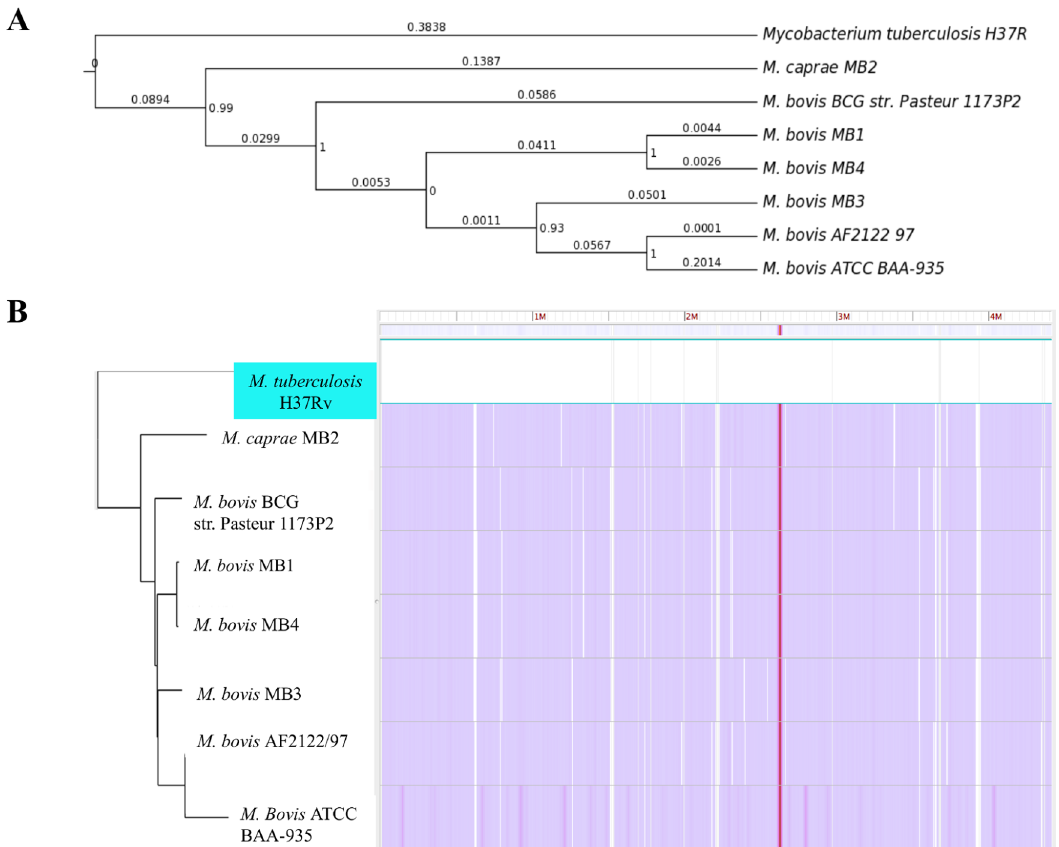
Fig 2. Phylogenetic analysis. (A) The phylogenetic tree showing the bootstrap scores (at the bifurcations) and the branchlength values (over the branches) was based on the SNPs included in the.vcf file provided by Harvest suite as the result of analyzing the core-genome alignment of the 7 genomes included in the phylogenetic analysis ( M . tuberculosis H37Rv was used as reference). The image was built using EvolView. (B) Screenshot of Harvest suite tool displaying the phylogenetic tree and the core-genome multiple alignment for the 7 genomes included in the analysis. Regions with sequence differences and discarded from the SNP analysis are shown in white. The regions included in the SNP analysis are colored with a similarity dependent color scale.